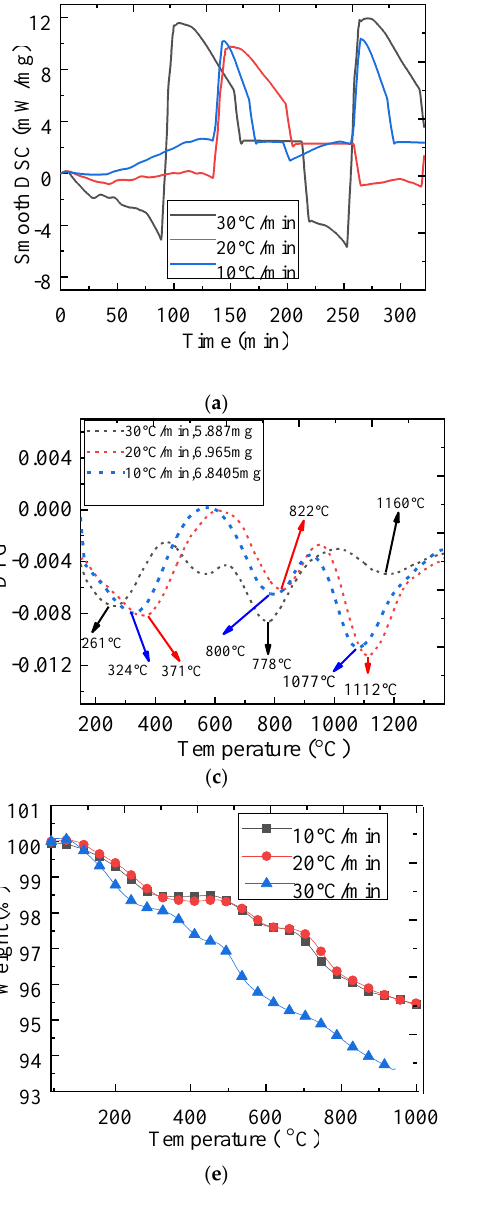
Figure 6. The impact of heat flow rate during redox reactions: ( a ) Changes in smooth DSC with time; ( b ) changes in enthalpy with charging temperature in cycle 1; ( c ) phase change indicator graph during cycle 1; ( d ) changes in conversion rate with charging temperature in cycle 1; ( e ) changes in TGA with charging temperature in cycle 1 and ( f ) changes in conversion rate during the whole charging – discharging time for both redox cycles.